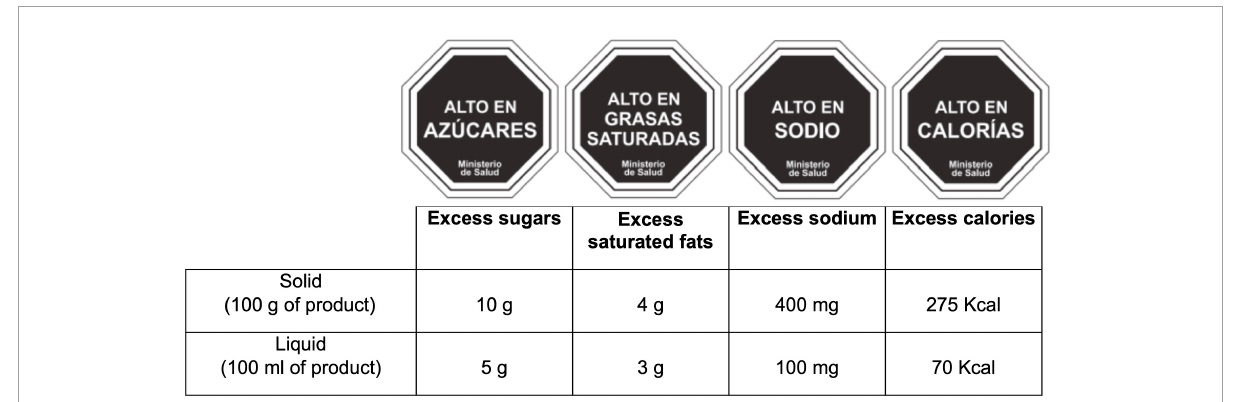
FIGURE1 Flow chart for participants included in the SUN project.